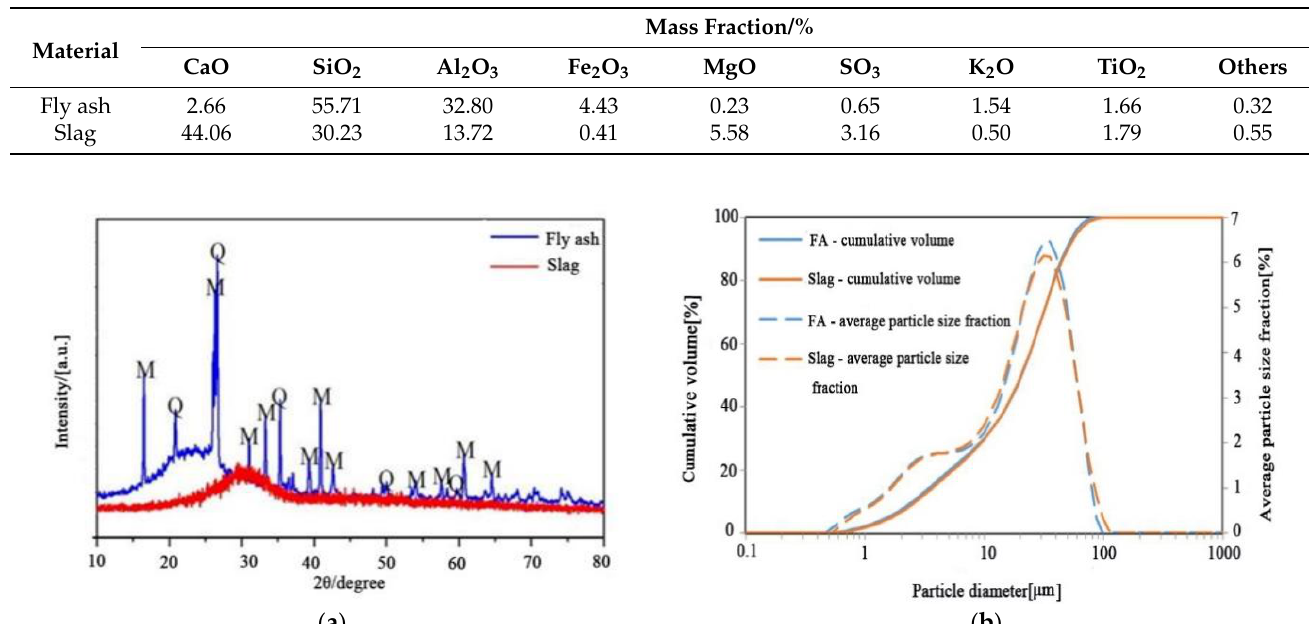
Table 1. Chemical composition of fly ash and slag.